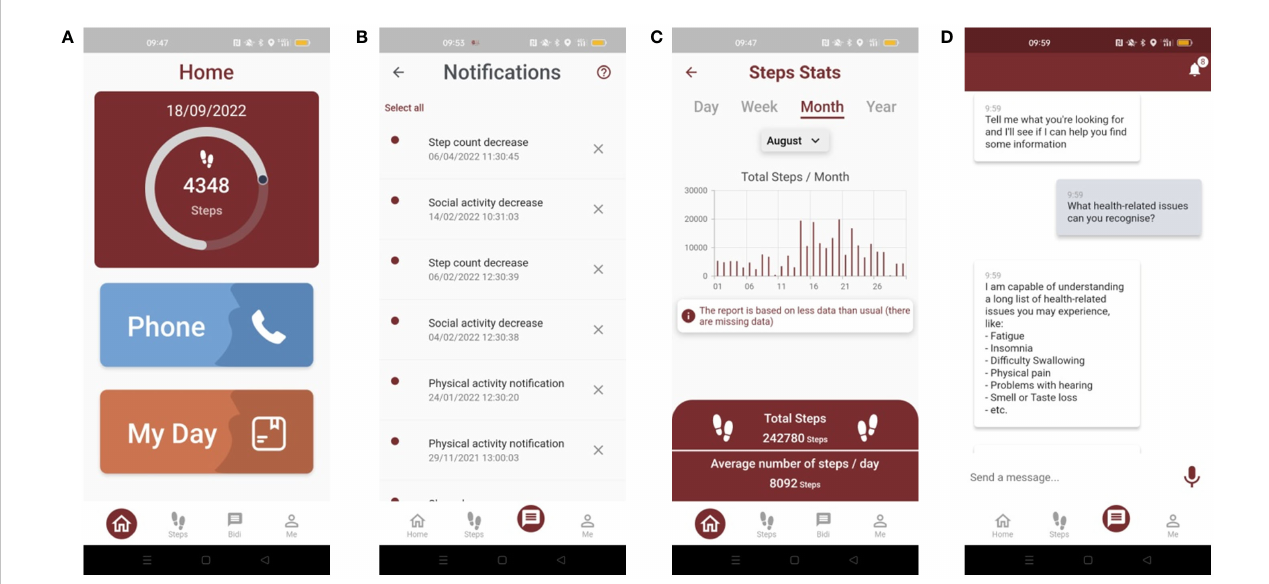
FIGURE 2 Screenshot of the BD4QoL study mobile app: (A) homepage, (B) noti fi cation dashboard, (C) monthly statistics of step count, (D) example of BiDi chatbot